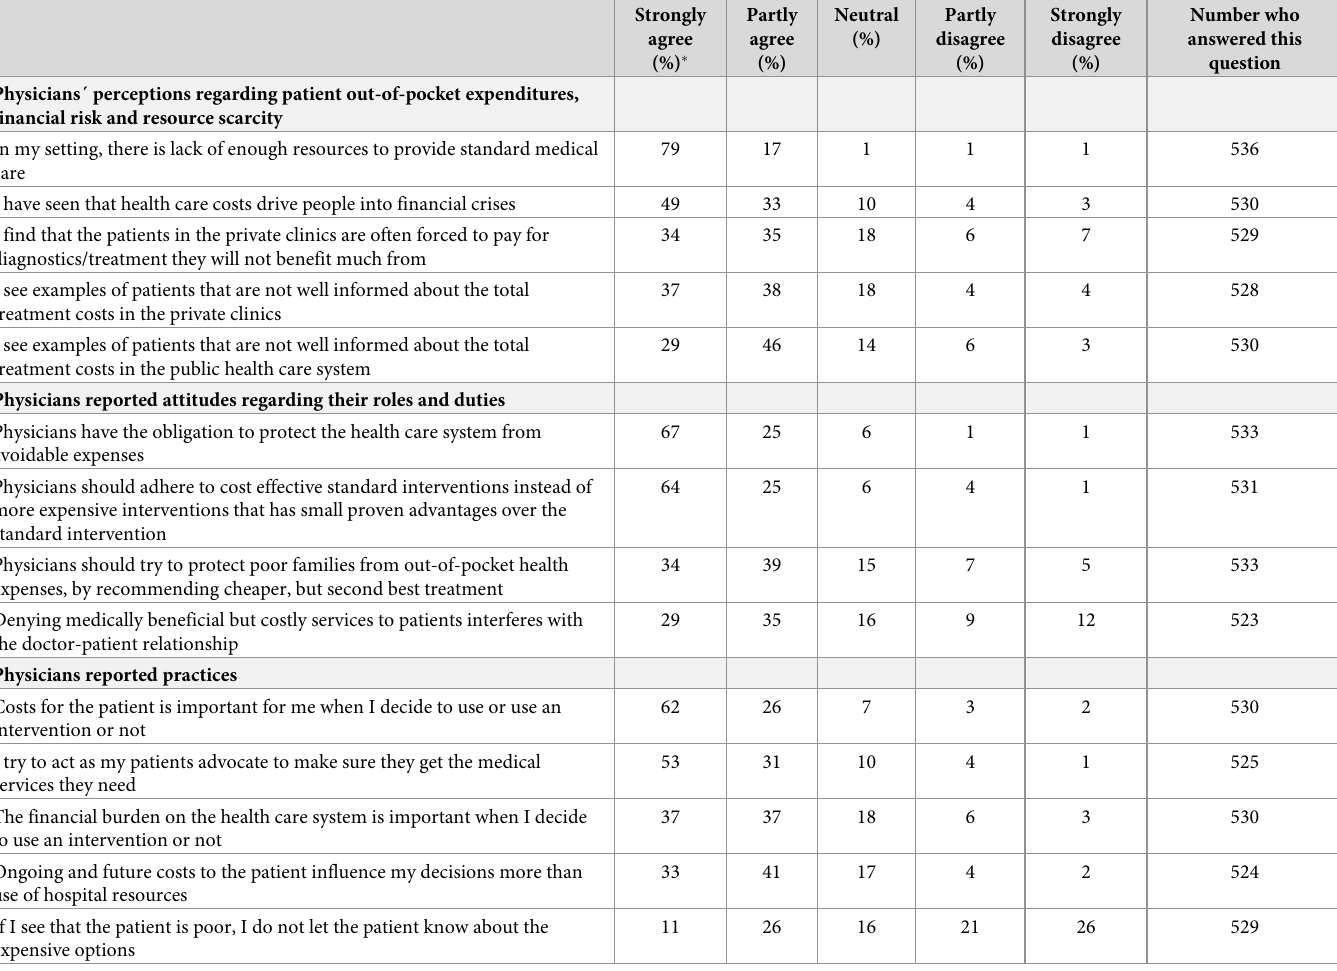
Table 3. Physicians’ perception on their patients’ health expenses, their own roles and duties and their reported practices of protecting their patients and their fam- ilies from health care costs. � For some of the criteria the total do not sum up to 100% due to